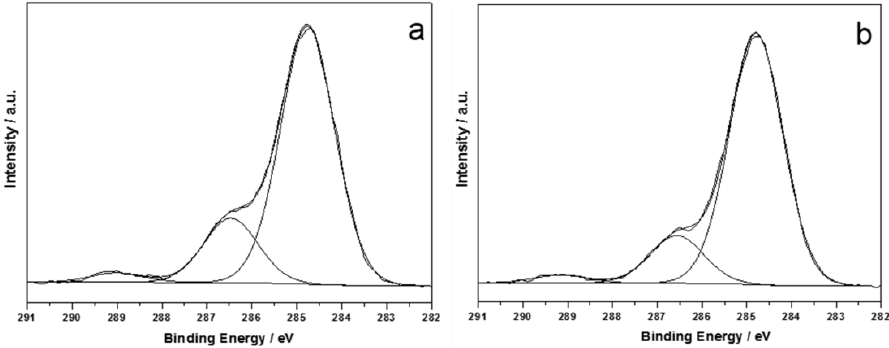
Figure 4. C1s XP-HRR of pristine leatherette ( a ) and treated leatherette ( b ).